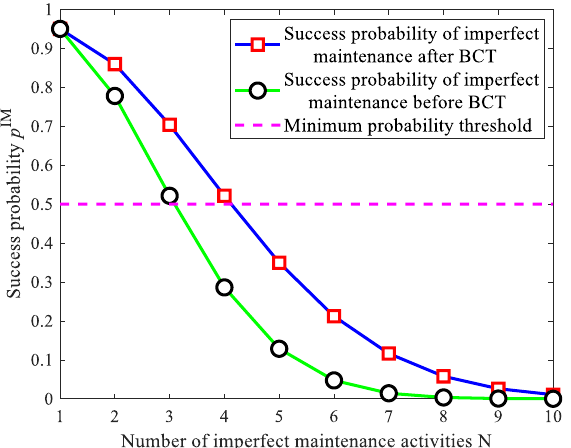
Figure 8. Probability of successful execution of imperfect maintenance activities .